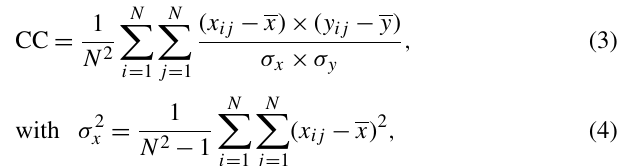
Figure 3. Latitudinal pattern for RF-RA and Hashimoto2015-RA. The grey area indicates 2.5th to 97.5th percentile ranges of the RF-